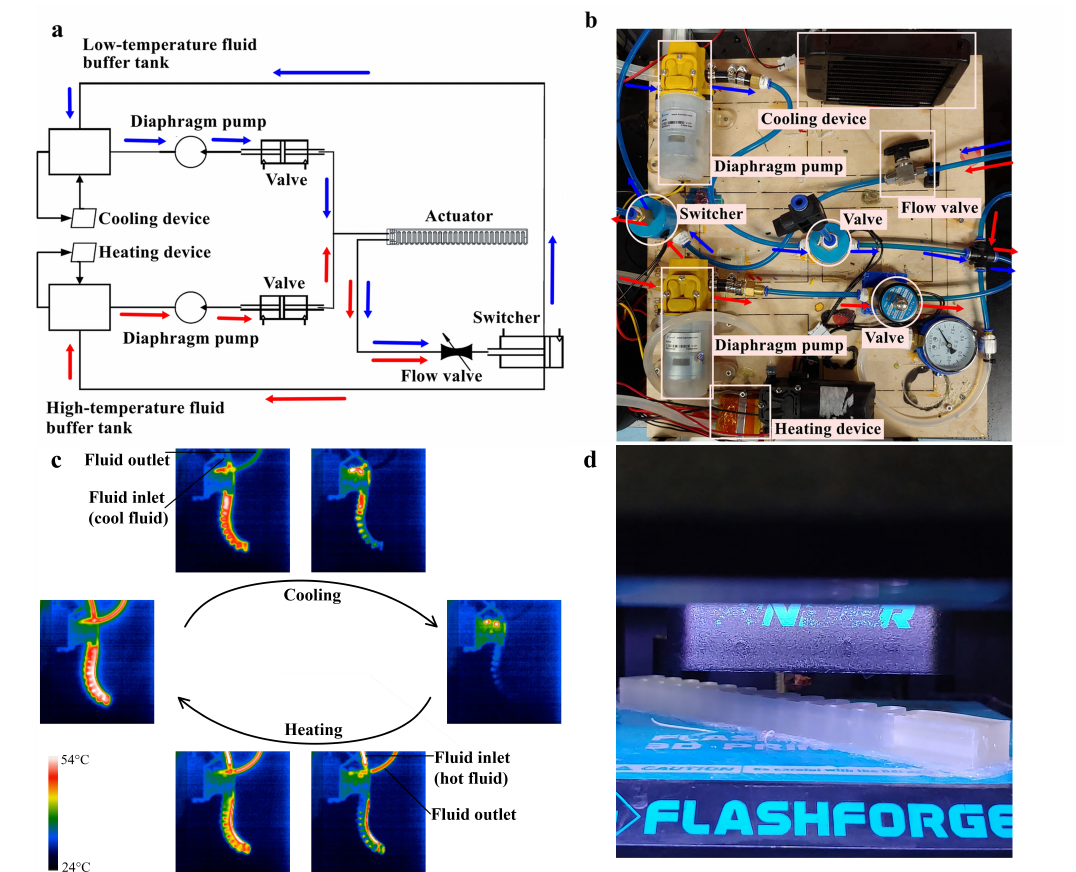
Figure 1. Control of the SMP-based variable stiffness actuator. ( a ) Schematic showing the setup used for controlling the stiffness variation and bending of the actuator. The driver system consists of a high-temperature fluid buffer tank, a heating device, a low-temperature fluid buffer tank, a cooling device, two diaphragm pumps, two valves, a flow valve, a switch. The blue arrow represents the flow direction of the low-temperature fluid, and the red arrow represents the flow direction of the high-temperature fluid. ( b ) An optical photo showing the setup of the driving system used for controlling the actuator. The blue arrow represents the flow direction of the low-temperature fluid, and the red arrow represents the flow direction of the high-temperature fluid. ( c ) Infrared thermographic images of the actuator during the heating (actuation) and cooling (relaxation) process. ( d ) An optical photo showing the 3D printing process during the fabrication of the actuator. The layer height is set as thin as 0.05 mm, and the print infill is 100%. The fabrication process (3D printing) of the actuator is shown in Movie